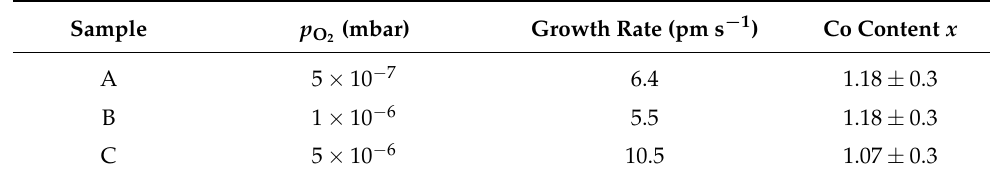
Table 1. Overview of the prepared samples with the respective oxygen partial pressure and the growth rate.